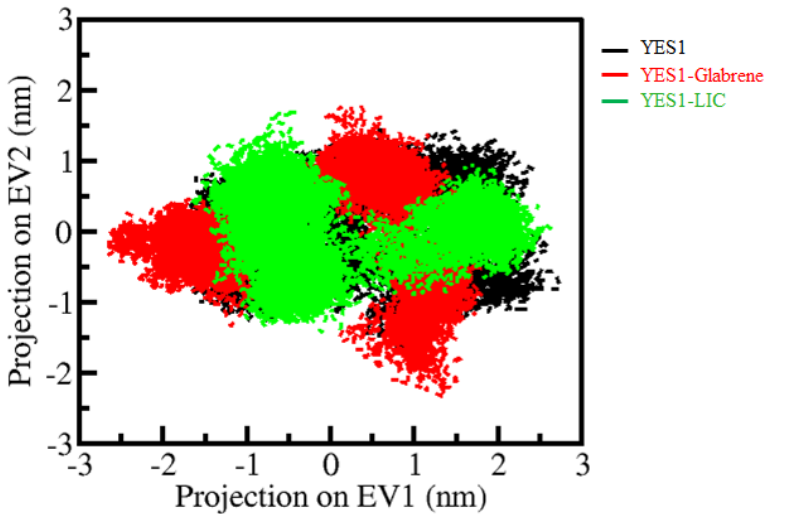
Figure 7. Principal component analysis. Two-dimensional conformational projections of YES1, YES1-Glabrene and YES1-LIC.